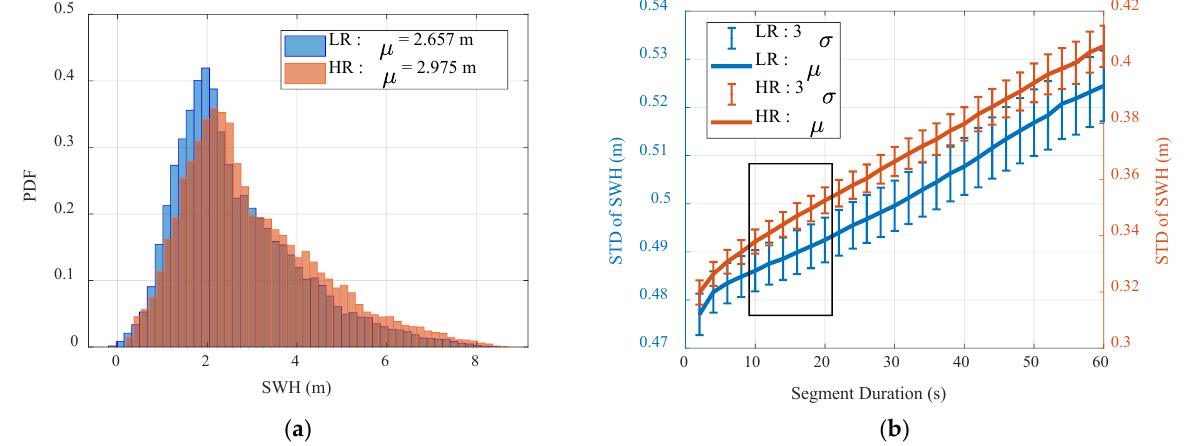
Figure 9. The statistical analysis results of SWH and its changes in the Sentinel-6 dataset: ( a ) the histograms of SWH in LR mode and HR mode; ( b ) the STD of SWH under different segment durations. The two thick curves stand for the mean values, and the vertical thin line bars indicate the 3 σ confidence intervals.